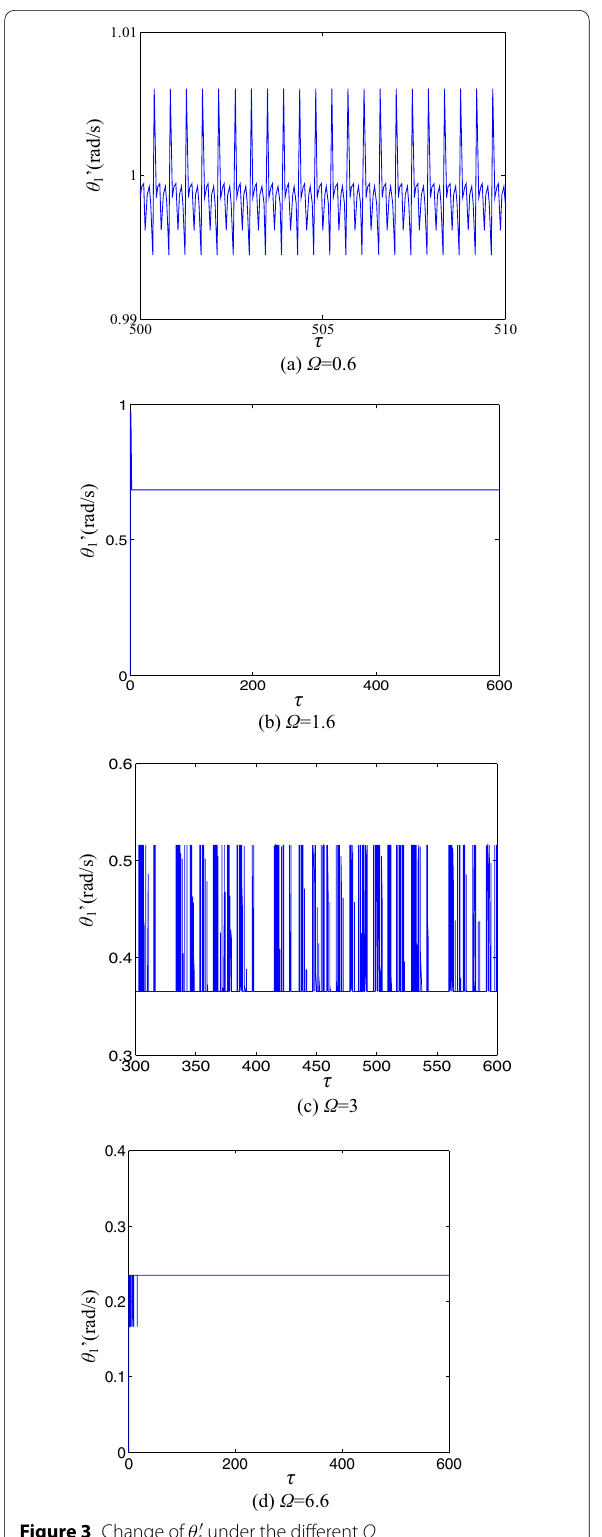
Figure 3 Change of θ ′ 1 under the different Ω